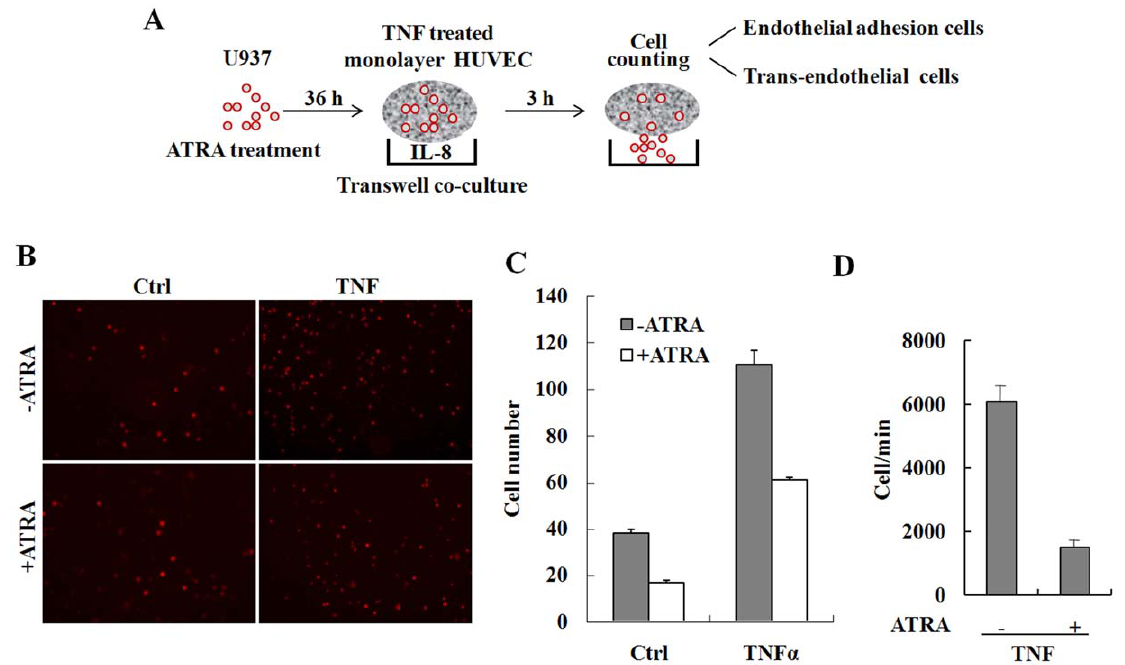
Figure 5. Inhibition of ICAM-1 N -glycan elongation or processing by ATRA suppresses trans-endothelial migration of U937 cells. A, Schematic presentation of the protocol used to determine the effect of ATRA on trans-endothelial migration of U937 cells. Briefly, U937 cells were treated with ATRA for 36 h and then co-incubated with the confluent monolayer of HUVEC cells, which were treated with 10 ng/ml TNF a and cultured on matrigel-coated transwell filters. 50 ng/ml IL-8 were added to the lower chamber. B to D, U937 cells attached to the HUVEC monolayer and trans-migrated through the matrix-membrane unit were estimated by confocal microscopy (B), cell counting (C) and flow cytometry (D).